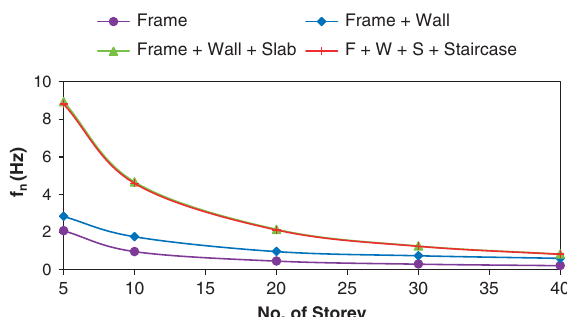
Fig. 13. Natural frequency, f n , for different con fi gurations compared to staircase inclusion